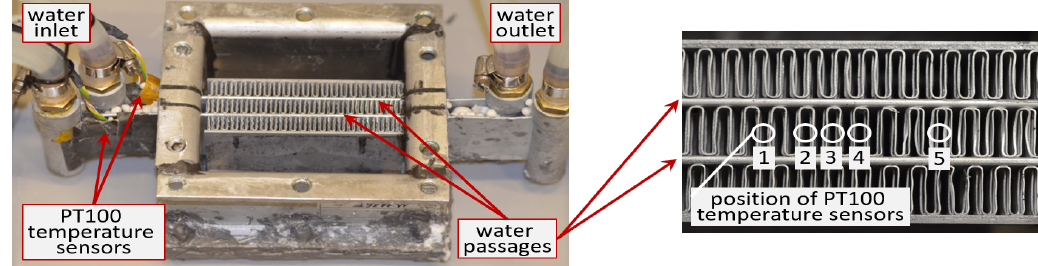
Figure 7. Experimental setup for the characterization of the PCM phase transition behavior in a compact extended surface HEX. The air passages are filled with PCM. Water flows through the two liquid passages. Five PT100 temperature sensors are installed in the middle between the two liquid passages to measure the temperatures in the PCM passage. Two PT100 are installed at the outer surface of the two liquid